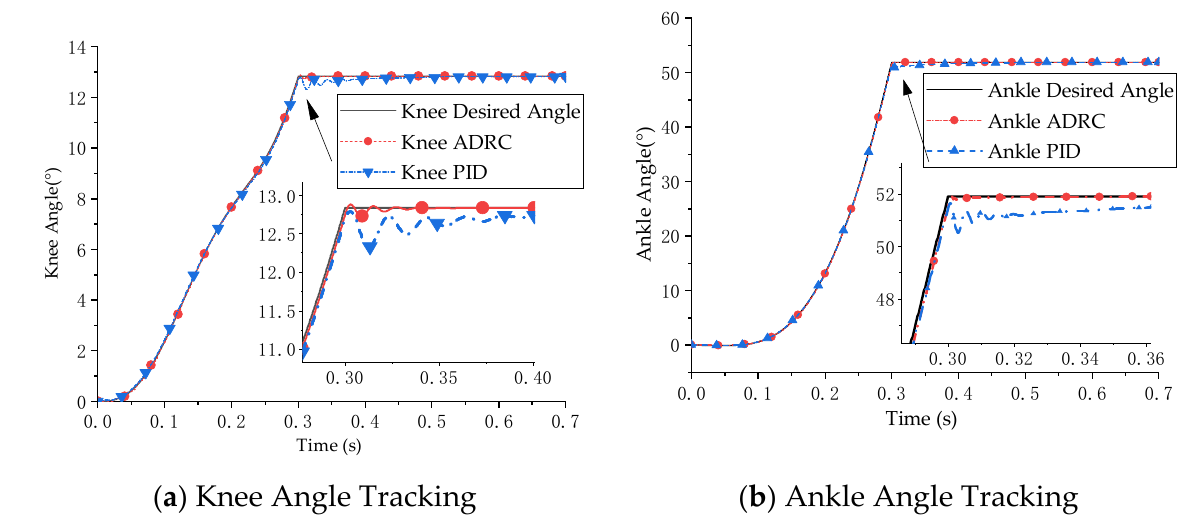
Figure 7. Simulation results of joint angle tracking control.